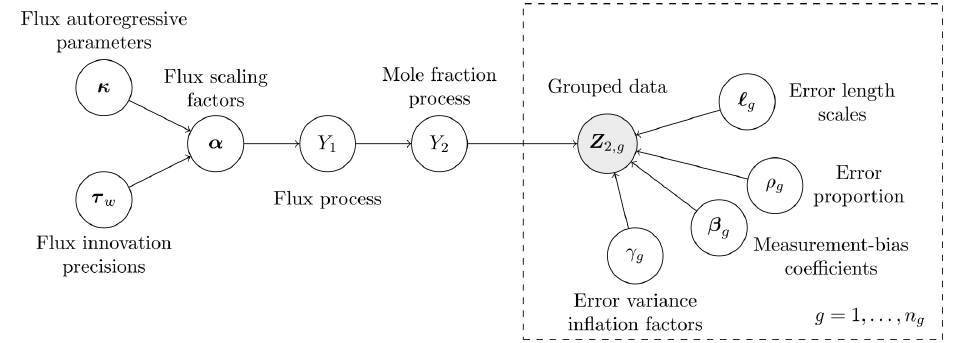
Figure 1. Graphical model summarising the relationship between the variables, processes, parameters to be inferred, and the grouped data { Z : g = 1 ,...,n g } 2 ,g